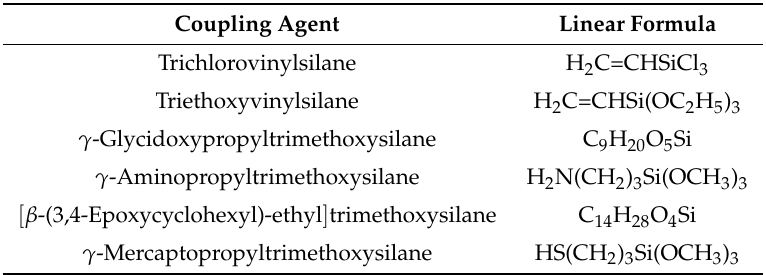
Table 2. Silane coupling agents characterizations